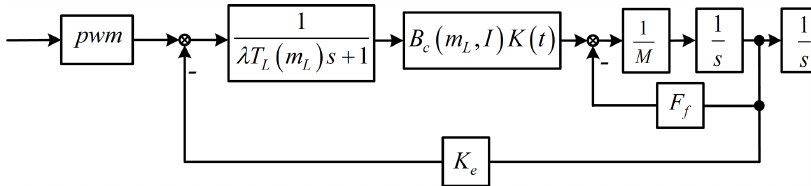
Figure 12. Kinetic model block diagram of macro-motion part.